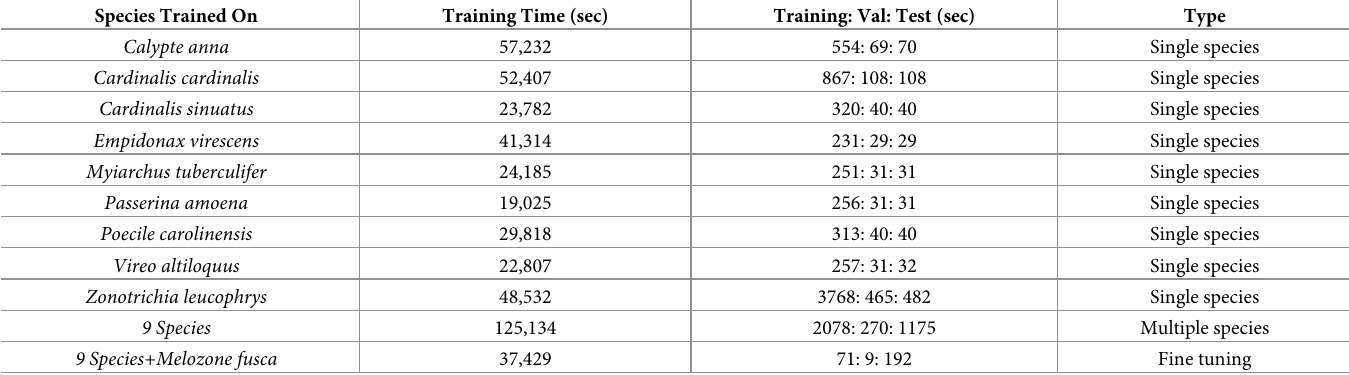
Table 1. Models trained in TweetyNet across multiple species vary in training time, dataset size, and type of model. “9 Species” models were trained on all data from the “Single species” type models. Species Trained